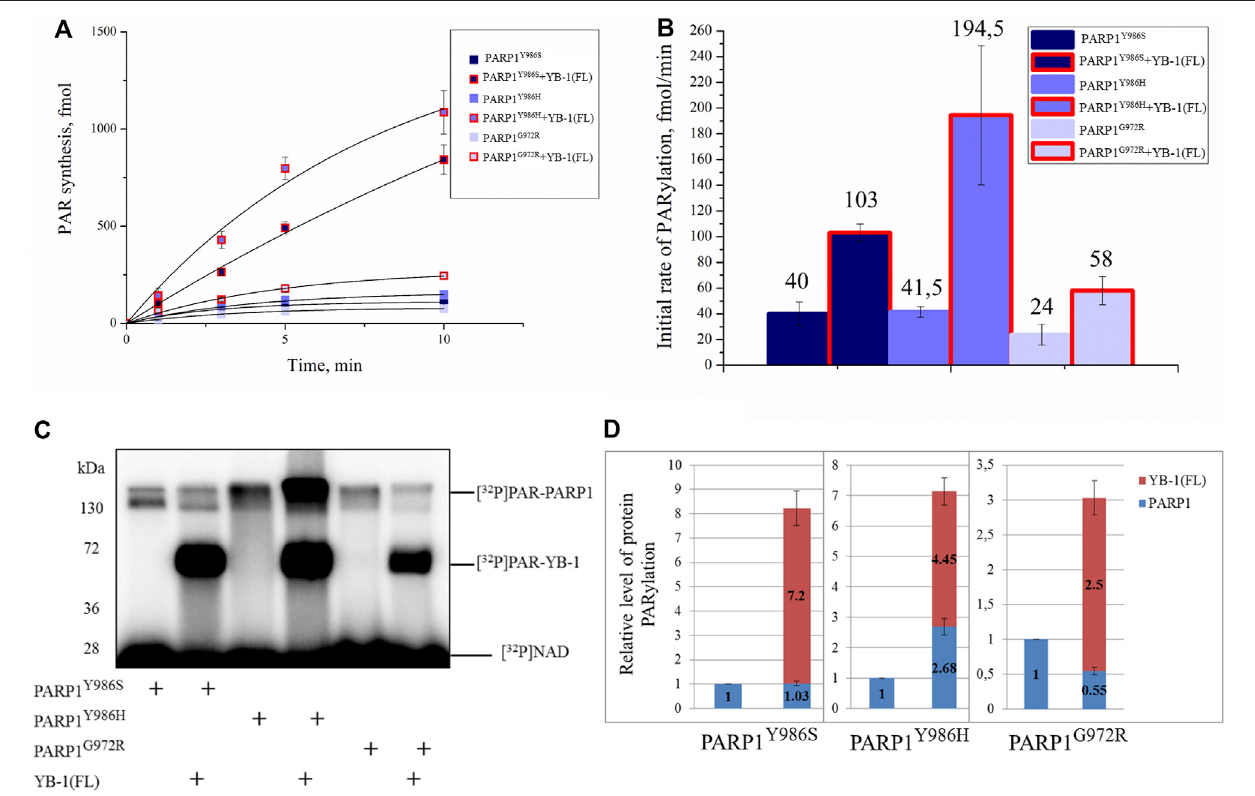
FIGURE9 | YB-1 stimulates theactivity ofPARP1point mutants. (A) The kinetics ofPARsynthesis catalyzed by PARP1 in the absence or presence of YB-1(FL) or itsdeletionmutants.Graphsrepresentthemeanvaluesofthreeindependentexperimentswitherrorbarsrepresenting±SD. (B) InitialratesofPARsynthesisestimatedin thepresenceofYB-1(FL).PARP1mutantsat100 nMwereincubatedwith0.5OD 260 /mlDNA act ,20 μ MNAD + ,and[ 32 P]NAD(0.4 μ Ci)inthepresenceof2.0 µMYB-1as indicated. [ 32 P]PAR-modi fi ed proteins were precipitated with TCA and counted. The initial rates (fmol/min) were determined from a direct analysis of progressive curve (A) which yields P max and k (Equations 1 and 3), and represent the mean ± SD of three independent measurements. (C) Auto-PARylation of PARP1 mutants and YB-1 trans-PARylation according to SDS-PAGE and phosphorimaging. The reaction mixtures consisted of 100 nM PARP1, 2.0 µM YB-1, 20 μ M NAD + [ 32 P]NAD (0.4 μ Ci), and 0.5 OD 260 /ml DNA act . (D) The diagrams present relative magnitude of PARP1 auto-PARylation and of YB-1 trans-PARylation (the mean of three independent experiments). The relative levels of PARylated proteins were normalized to the autoPARylated PARP1 mutant